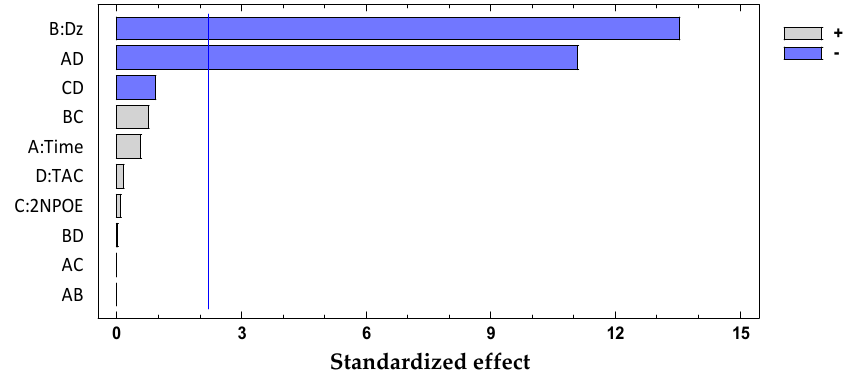
Figure 4. Desirability pareto chart after DoE analysis for the system Dz-Hg(II). Table 2. Analysis of variance (ANOVA) results for the system Dz-Hg(II).